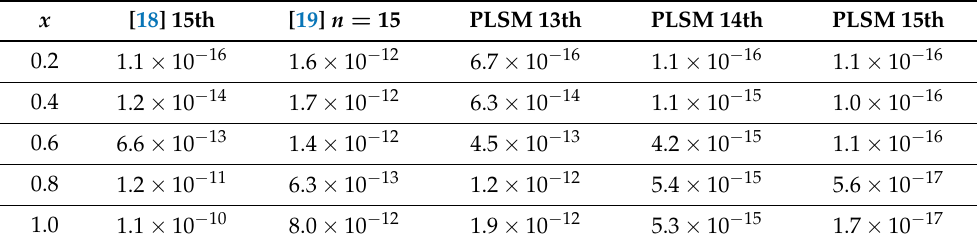
Table 4. Absolute errors of the approximations for problem